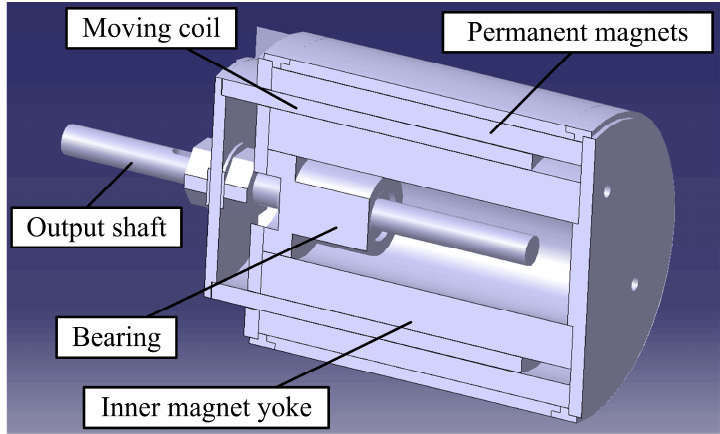
Figure 2. The structure of the ELA.